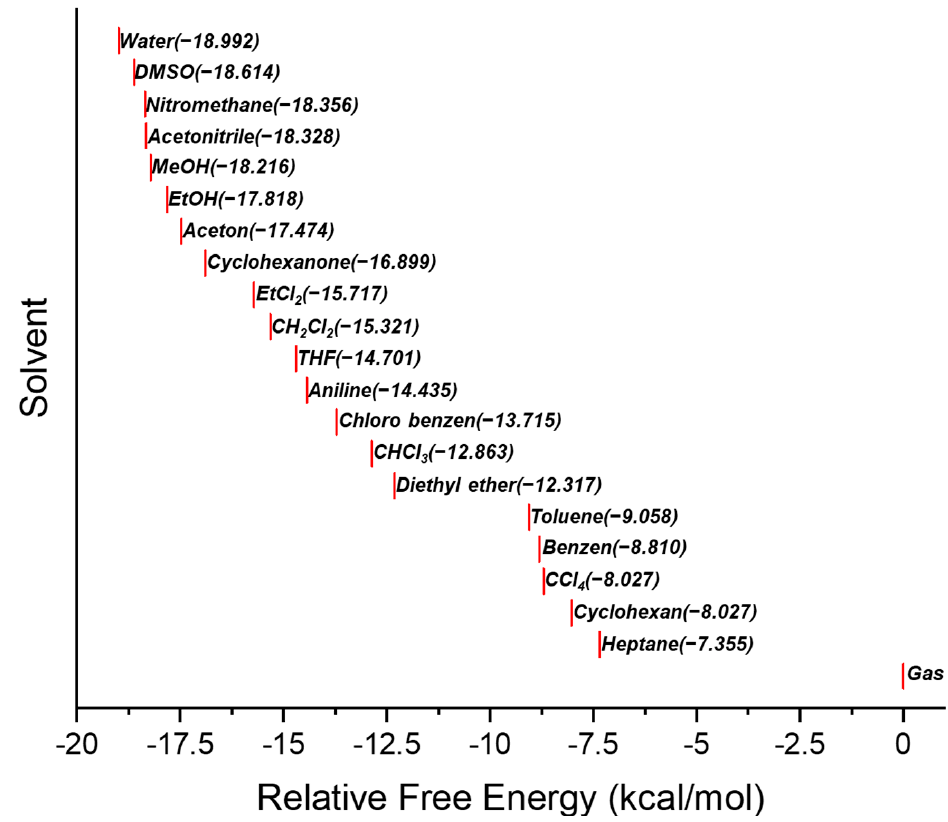
Figure 5. Effect of solvent on the transition state of asymmetric nitroso aldol reaction. The calculations were performed using various solvent conditions based on the B3LYP/6-31G(d,p) method.